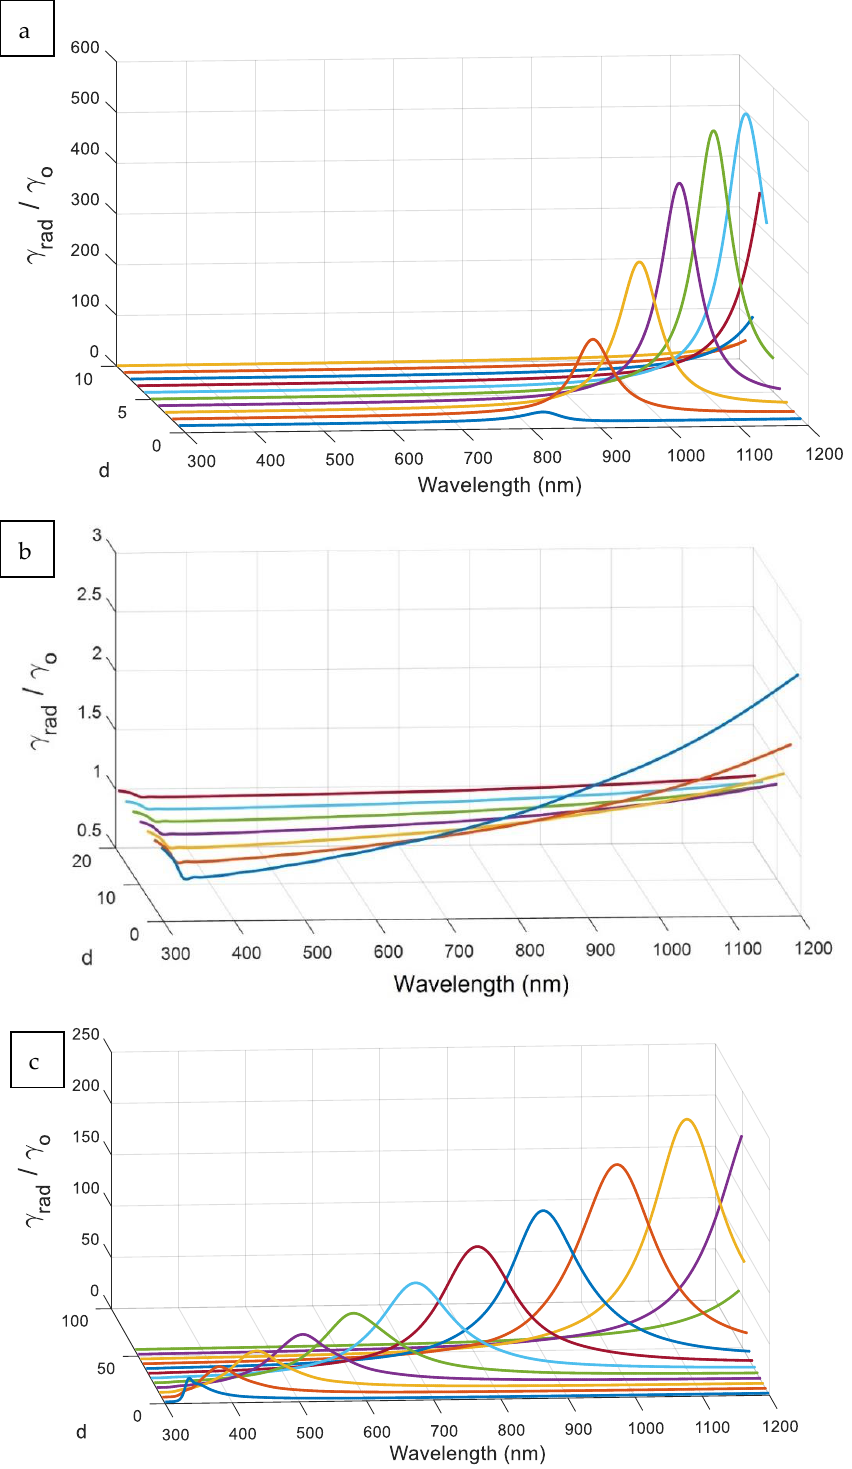
Figure 6. The radiative decay rate curves with the change of the distance d between the excited atom and the silver NPs with different aspect ratio ( a ) (c/a) = 5, ( b ) (c/a) = 1, and ( c ) (c/a) = 0.2. In Figure 7, the spectrum of the radiative decay rate of the ellipsoid and the sphe- roid are presented at different aspect ratios for certain distances, as examples. The spec-